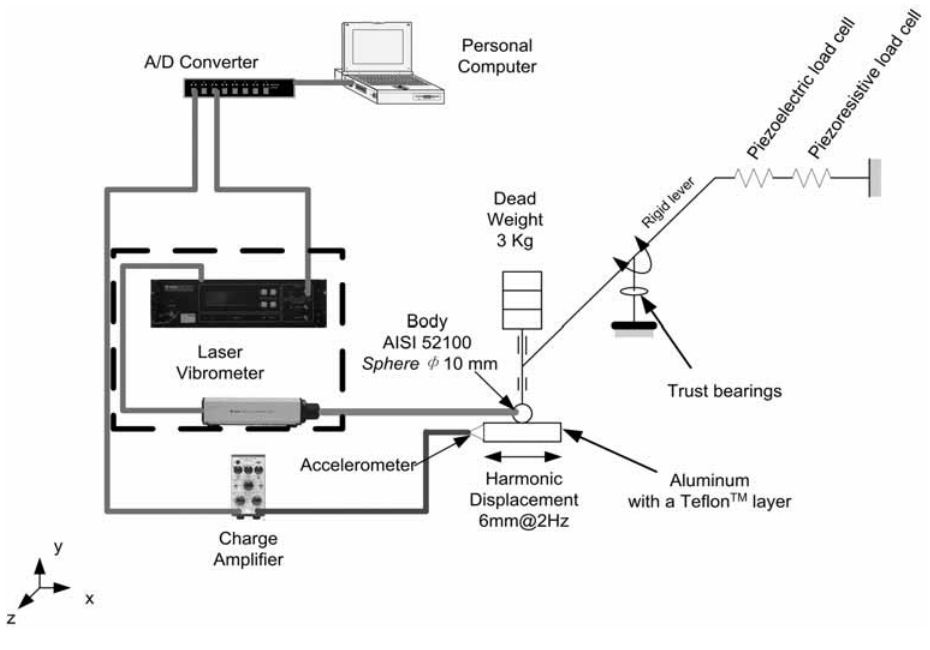
Fig. 13. Schematic diagram of the tribometer and the instrumentation chain.